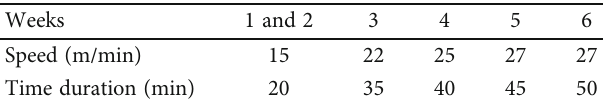
Table 1: Endurance training protocol on a treadmill with zero